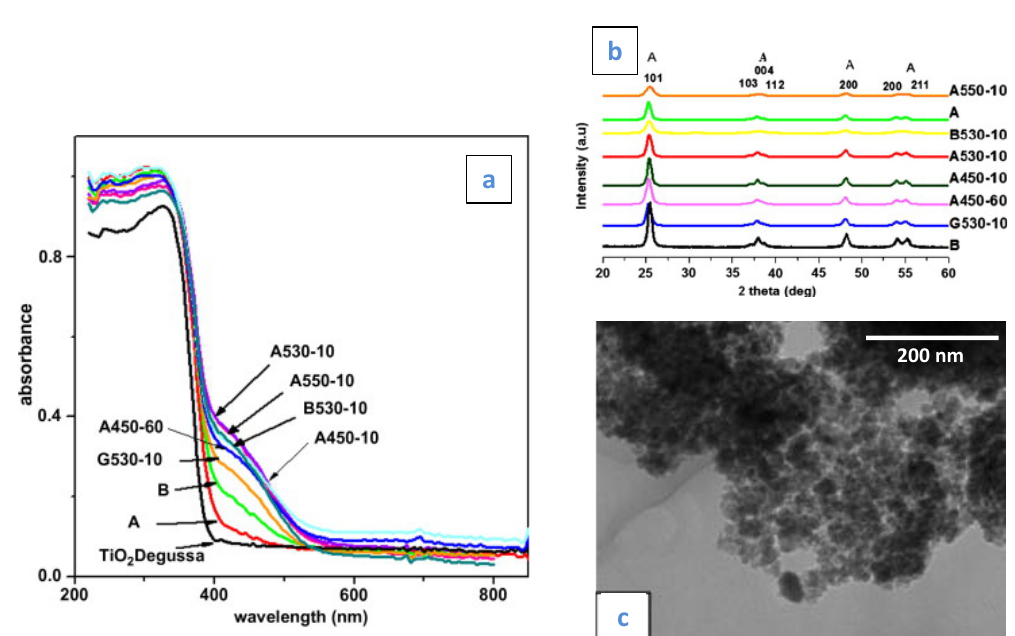
Figure 8. Diffusive reflectance spectra ( a ) and XRD patterns ( b ) of the N-doped TiO 2 aerogel and of reference samples; ( c ) TEM image of the N-doped TiO 2 aerogel A530-10, which gave the highest photocatalytic activity. In the figures, A refers to undoped TiO 2 aerogel, B refers to urea-doped TiO 2 aerogel, G refers to undoped TiO 2 xerogel, whereas the samples immersed in NH 3 are identified by the temperature and time of the thermal treatment that followed the immersion step (e.g., A530-10 is sample A that was thermally treated at 530 °C for 10 min after immersion in NH 3 ). (Adapted with permission from [65]. Copyright Elsevier, 2010).